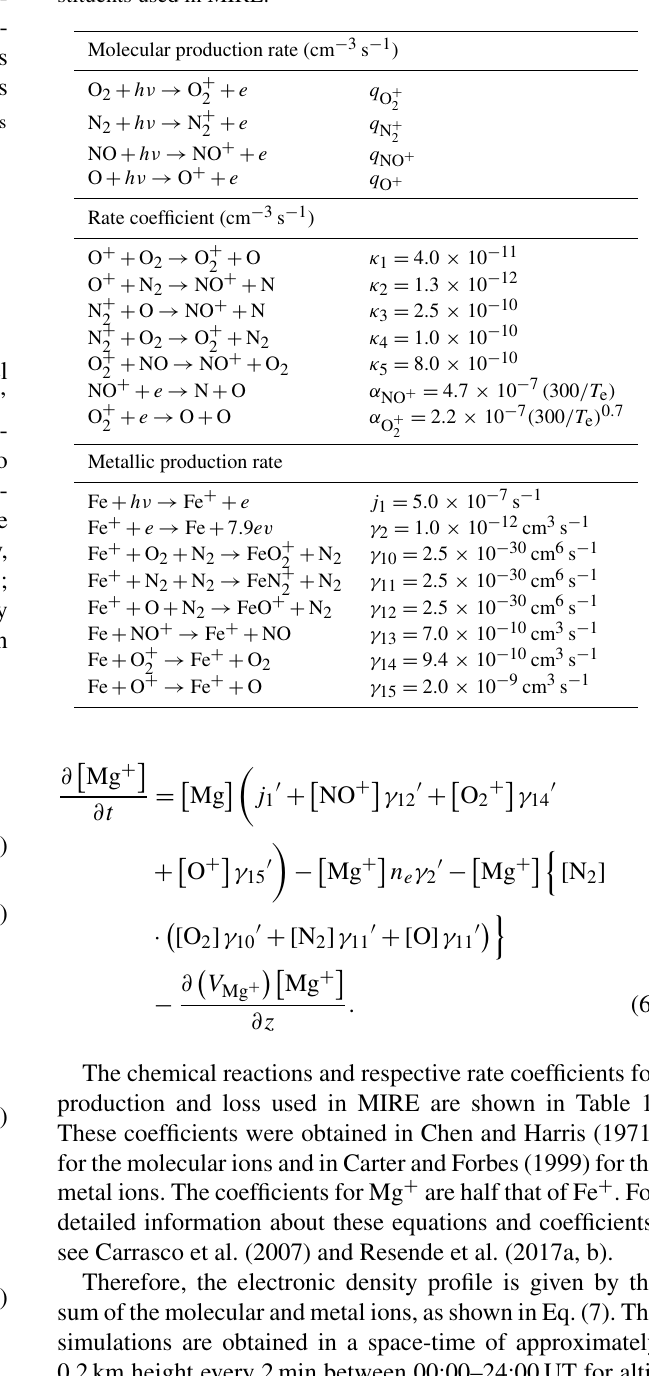
Table 1. Chemical reactions for the molecular and metallic con- stituents used in